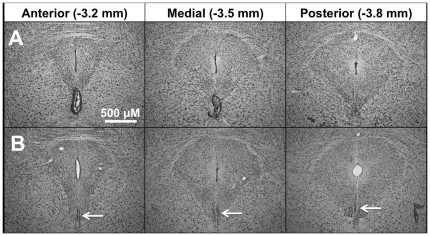
EWcp lesion histology.Representative photomicrographs of Thionin-stained sections from anterior, medial, and posterior EWcp (numbers indicate distance from bregma) taken from mice that underwent (A) successful EWcp lesion surgery or (B) sham surgery. Lesions generally ablated large portions of the anterior and medial EWcp, leaving minimal damage to surrounding tissue. Sham animals displayed no evidence of damage to the EWcp, despite occasional visibility of the electrode tract (posterior panel). White arrows point toward intact EWcp observed in sham animals.